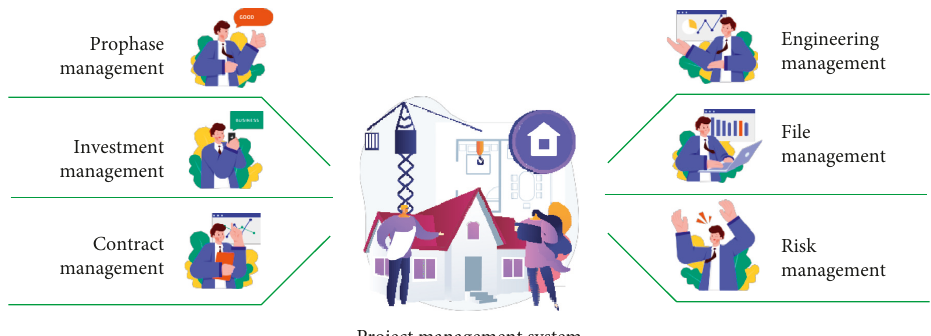
Figure 1: Construction project management